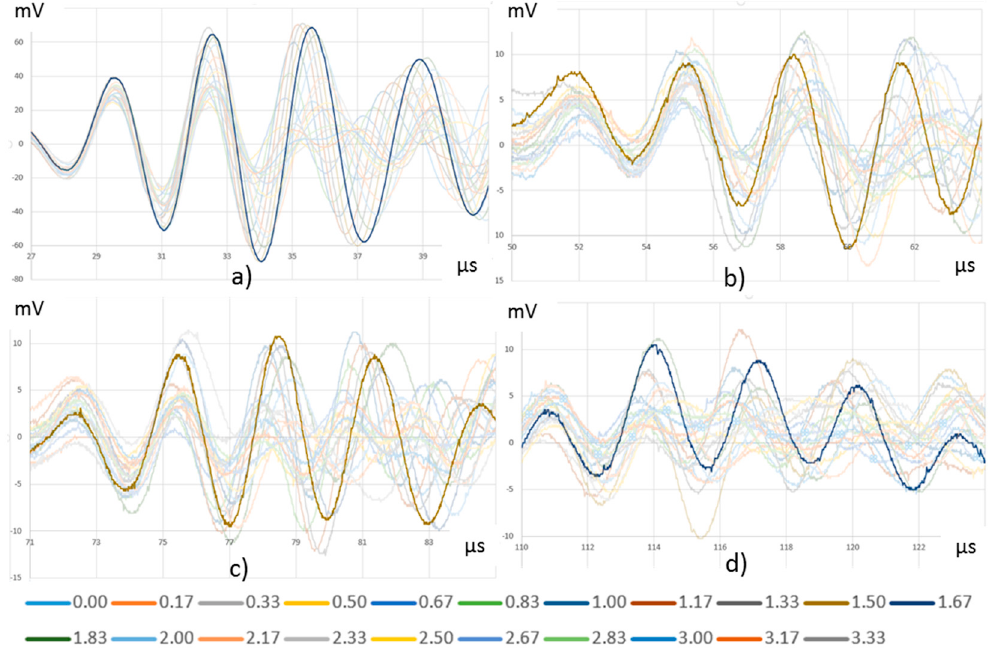
Figure 11. Acquired signals in PWAS ( a ) R5, ( b ) R6, ( c ) R7, and ( d ) R8 as function of the excitation signal delay applied to E6–E4. The received highest peak-to-peak amplitude for each PWAS is highlighted.